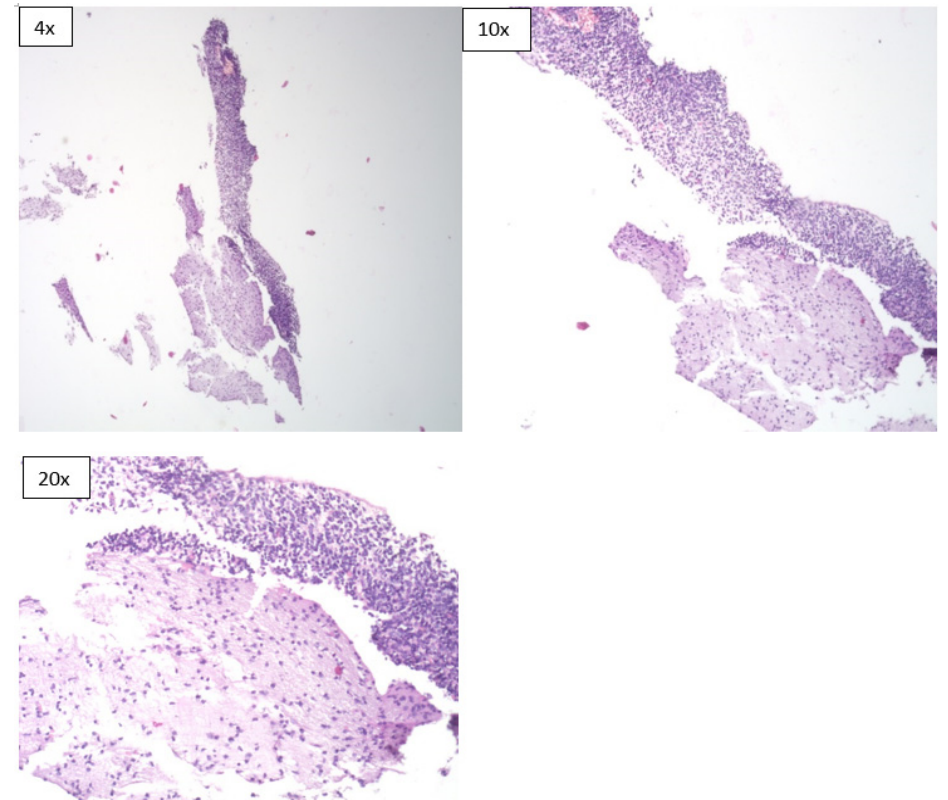
Figure 1. Microscopic sections of brain tissue obtained during the MITS procedure (H & E *). * Hematoxylin and eosin stain.